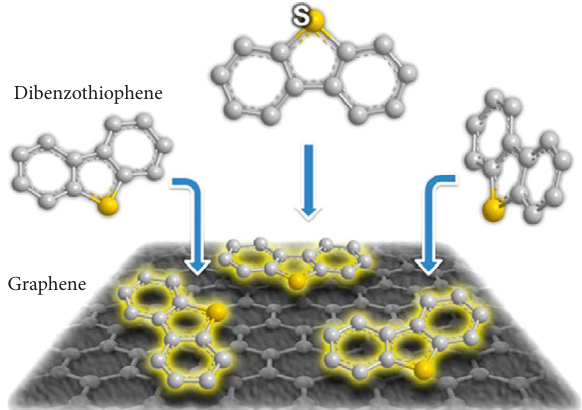
Figure 7: Adsorption of DBT on graphene via π -complexation (image taken from [23]).